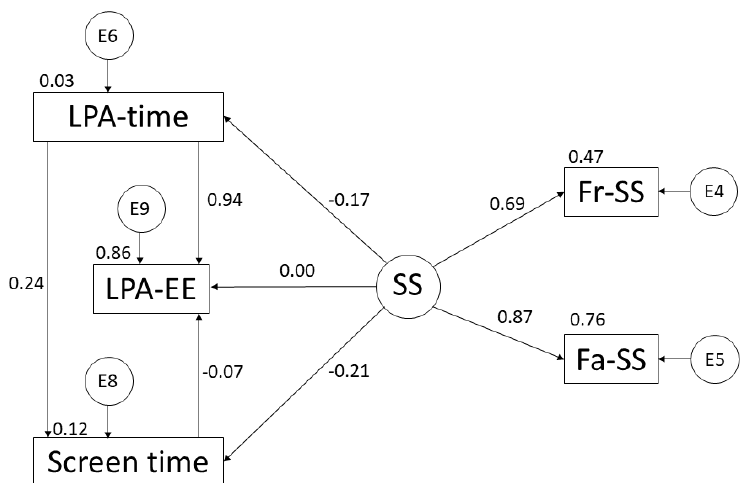
Figure 3. The proposed model in relation to light physical activity. Light Physical Activity Time (LPA-time); Light Physical Activity Energy Expenditure (LPA-EE); Screen Time (ST); Social Support (SS); Support from Friends (Fr-SS); and Support from Family (Fa-SS). Table 1. The model developed for light physical activity. Associations between